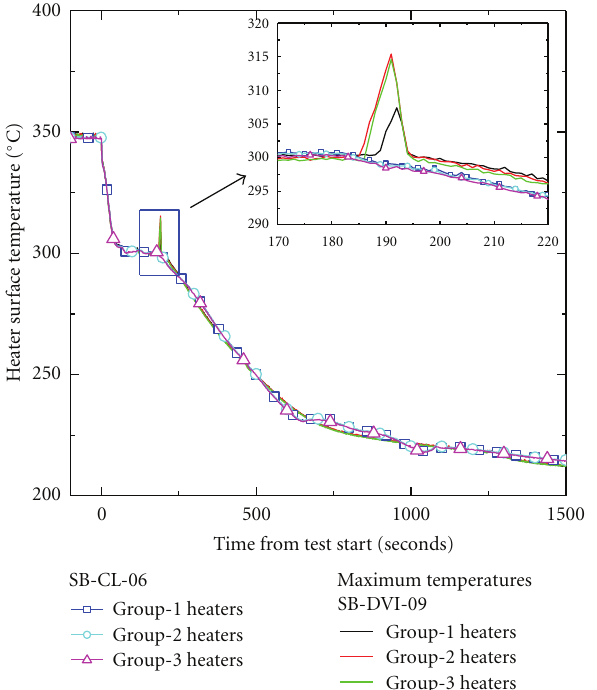
Figure 19: Primary and secondary pressure behavior during SB-